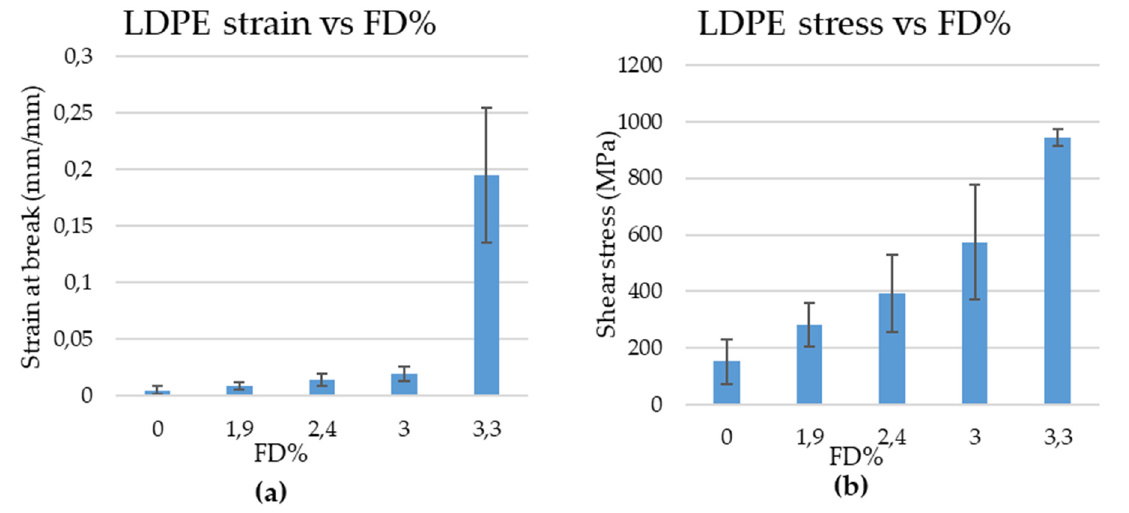
Figure 10. Strain ( a ) and stress ( b ) at break for grafted LFPE samples with different FD.